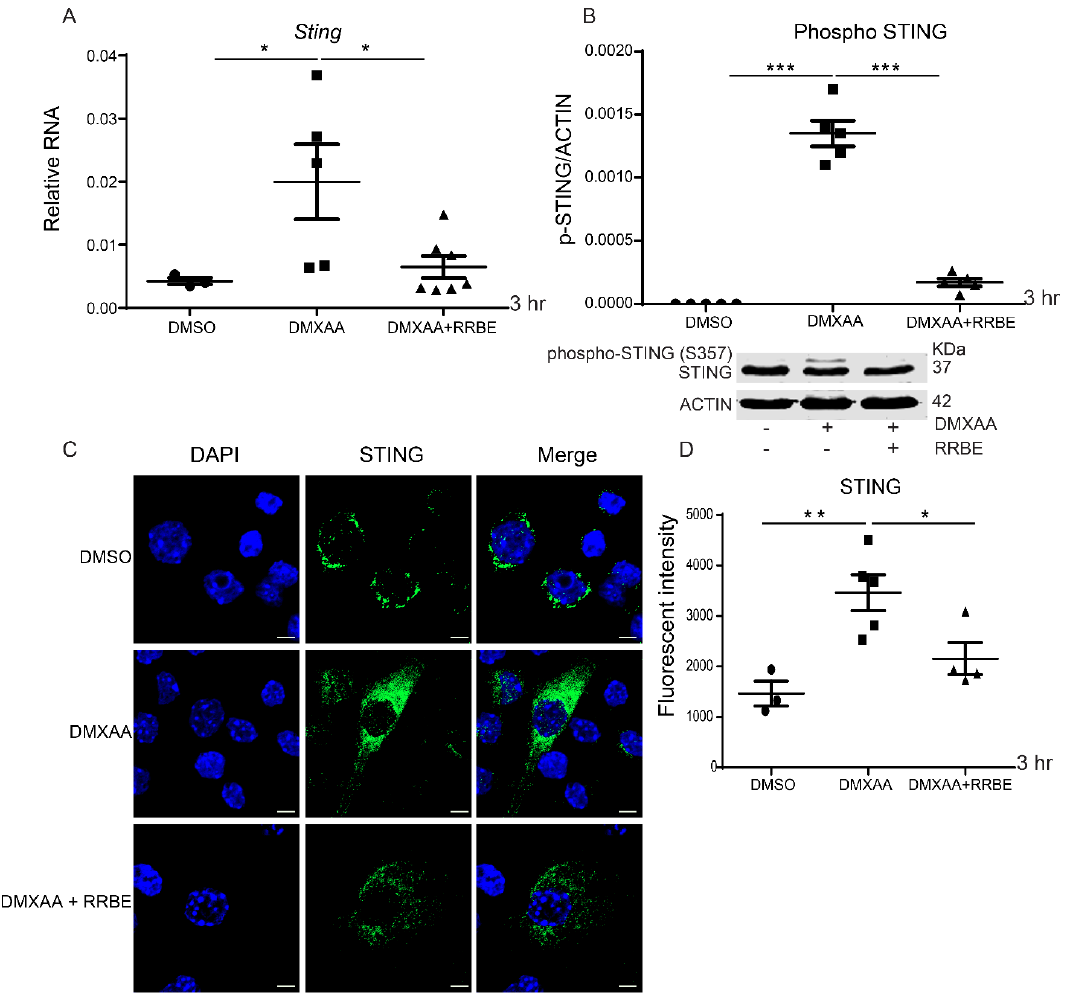
Figure 5. Effects of RRBE on STING activation. ( A ) The mRNA expressions of Sting are shown (N = 3 – 4). ( B ) The cell lysates were extracted, and Western blotting was used to analyze STING and phospho–STING protein levels after DMXAA activation with and without RRBE for 3 h (N = 3–4). ( C ) Confocal microscope of the activated cells staining RAW 246.7 cells shows STING (green) and DAPI (blue) (scale bar, 10 µm). Representations of three experiments and ( D ) the fluorescent intensity of STING expressions are shown. Data shown as mean ± SEM (* p < 0.05, ** p < 0.01 and *** p < 0.001).